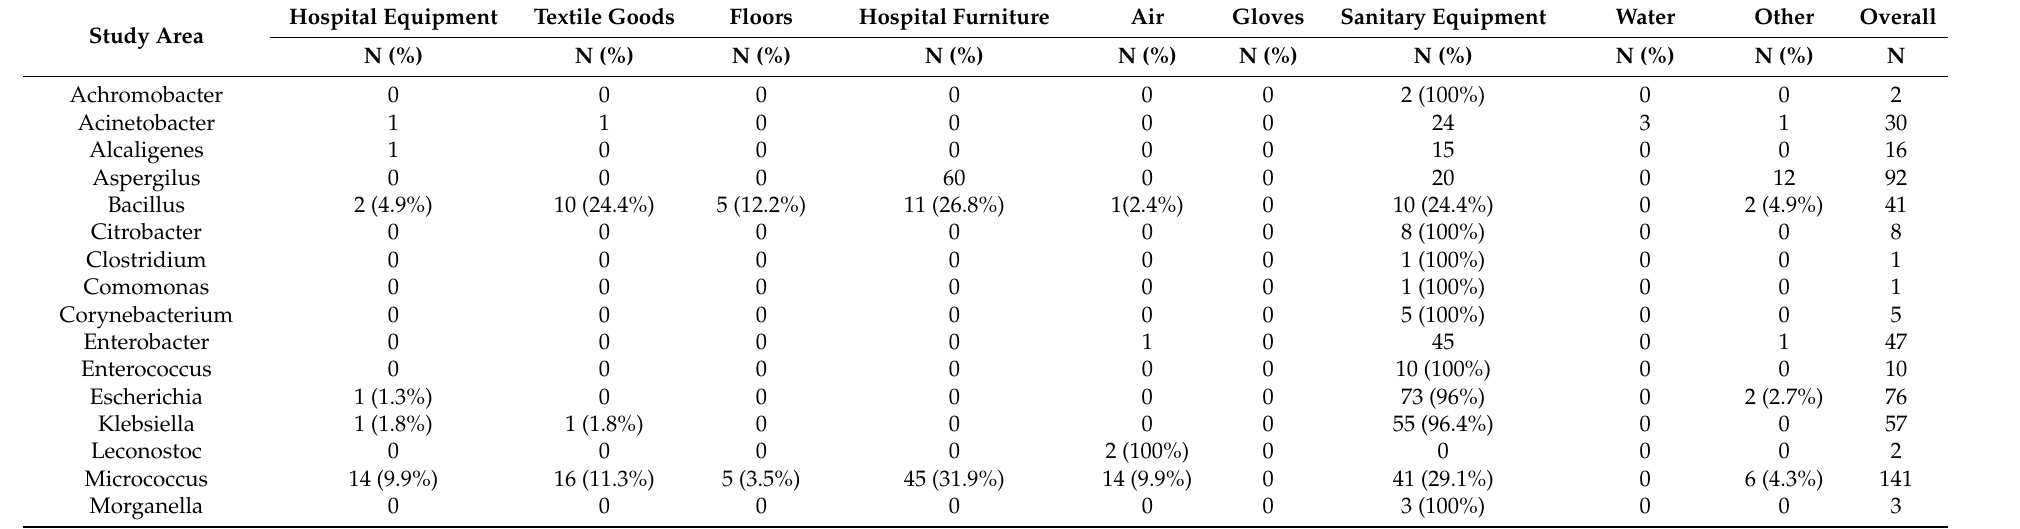
Table 6. Distribution microorganism type by the sampling area 1